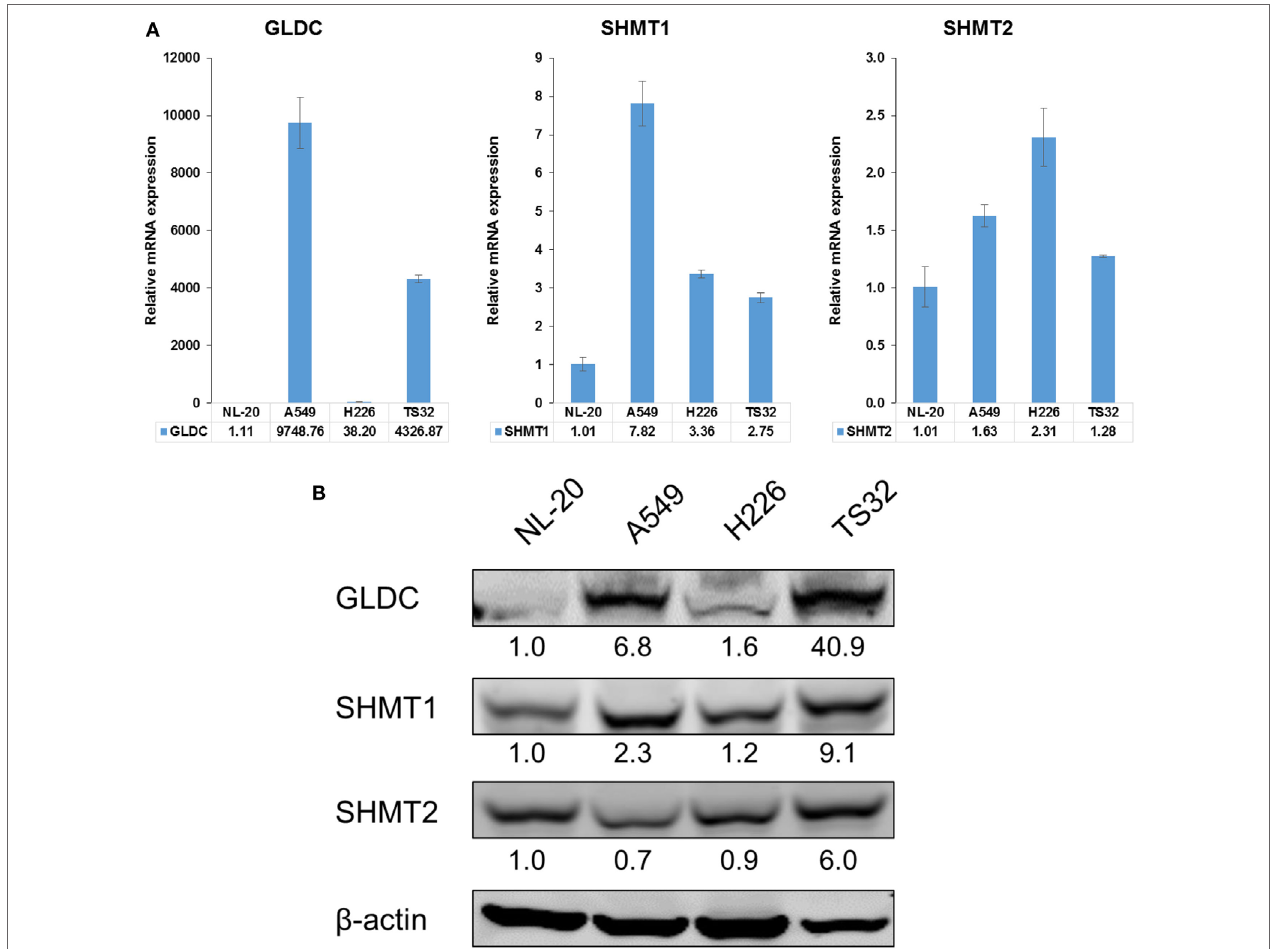
FigUre 1 | Glycine decarboxylase (GLDC) is overexpressed in lung cancer cells. (a) The mRNA expression of serine–glycine metabolic genes. The comparison was made between several lung cancer cell lines (A549, H226, and TS32) in relative to an immortalized normal lung cell line (NL-20). The data represent mean ± SD of triplicate polymerase chain reaction reactions. (B) The protein expression of serine–glycine metabolic genes in several lung cancer cell lines versus NL-20 cells. The densitometry values were in relative to NL-20 after normalization to β -actin. The data are the best representative of three independent